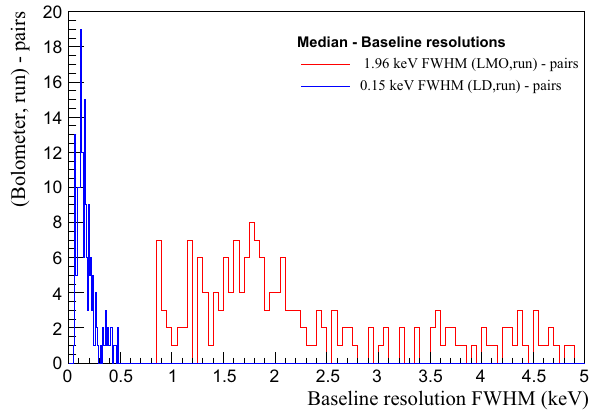
Fig. 11 Baseline resolution (FWHM) distributions for 183 (LD, run) and 189 (LMO, run) pairs. LMO 2 and LD 3 are rejected, as are periods with atypical noise